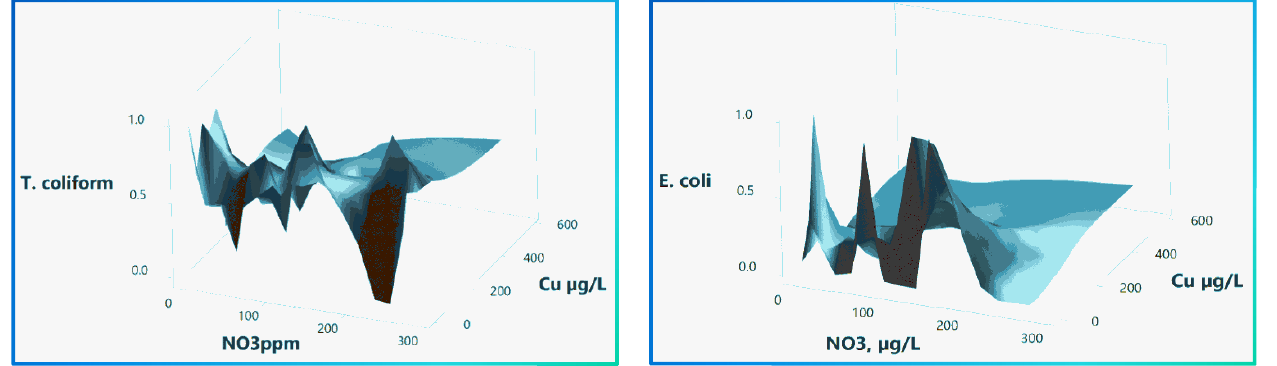
Figure 13. 3D surface plot of the combined interactions of Cu and nitrate concentrations on TC ( left ) and E. coli ( right ).